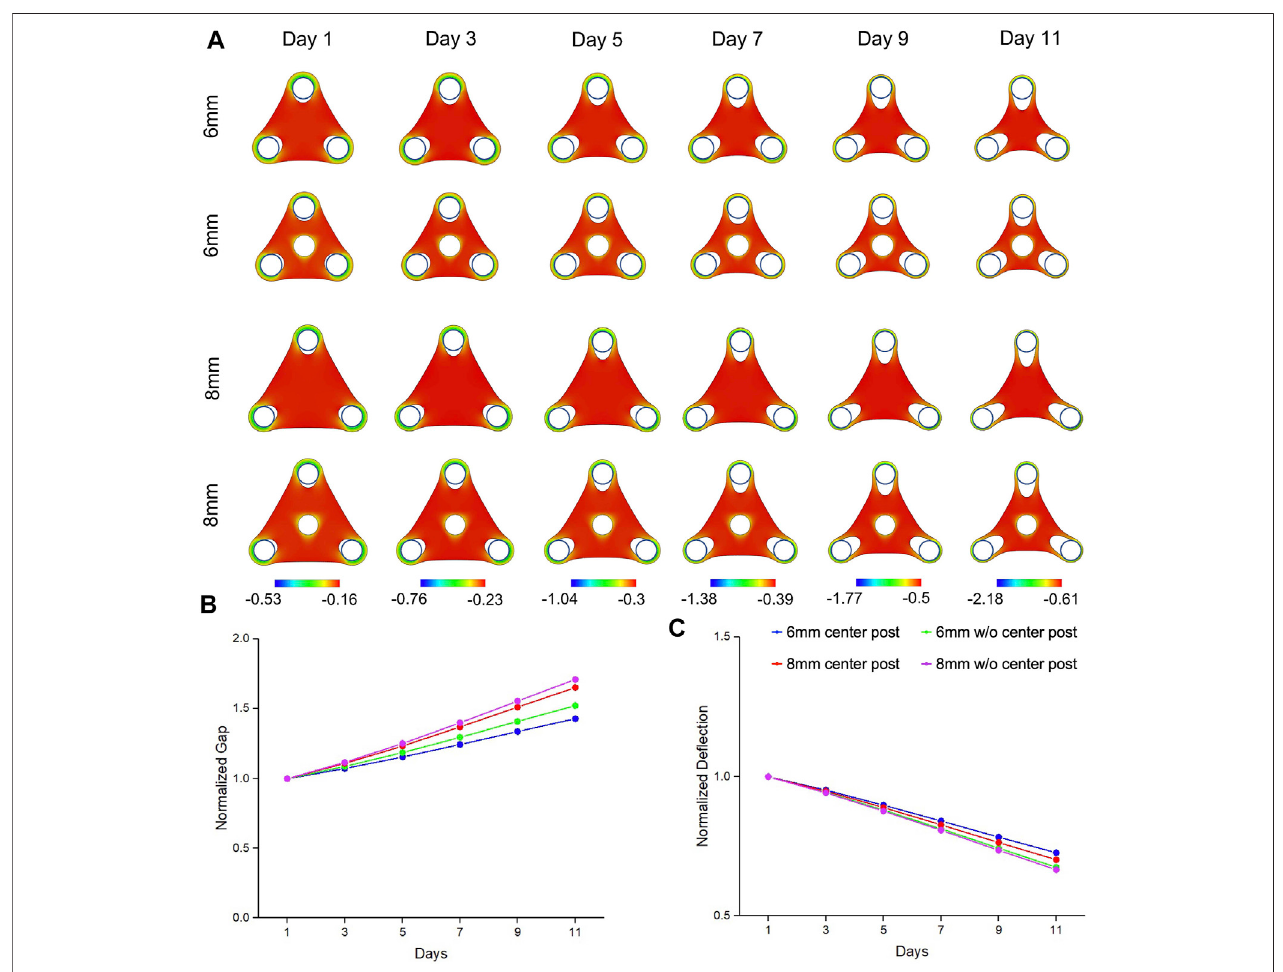
FIGURE2| Simulation resultsofmorphogenicevolutionoftriangular mesenchymal tissues. (A) Avolumetric contraction model with atime-dependent free-energy function was used to simulate the morphological evolution of the triangular tissues. The color represents the minimal principal logarithmic strain distribution. The computational model was able to replicate the trends in morphological changes of gap extension and de fl ection compaction that were observed from the experimental model. For the tissue comparison ( ▲ 6wC, ▲ 8wC, ▲ 6woC and ▲ 8woC), (B) the gap was larger and (C) the de fl ection was smaller for the triangular tissues with longer side length and without the center